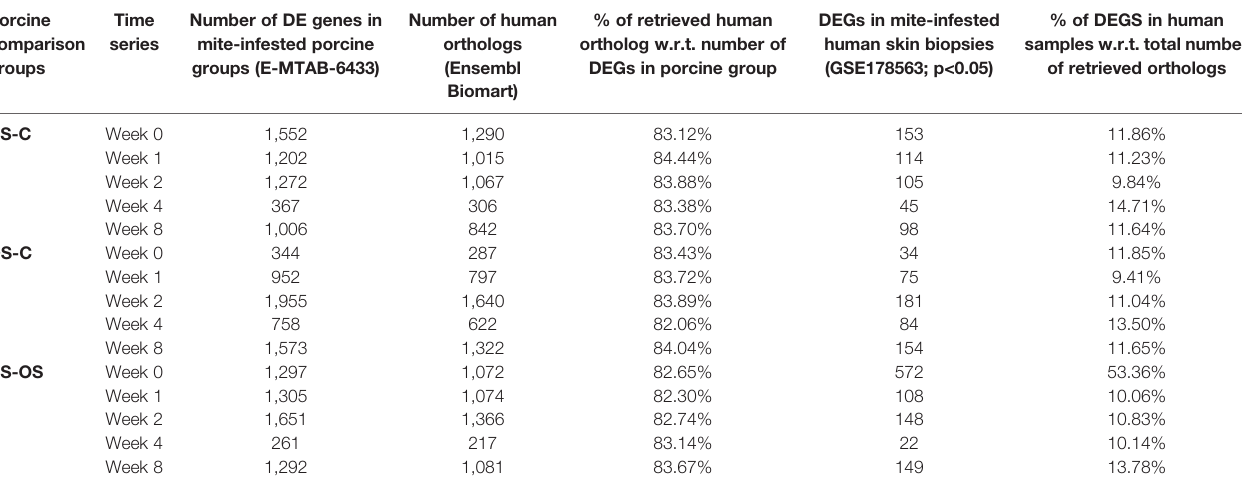
TABLE 2 | Number of differentially expressed genes in mite-infested porcine and human samples. Porcine comparison groups